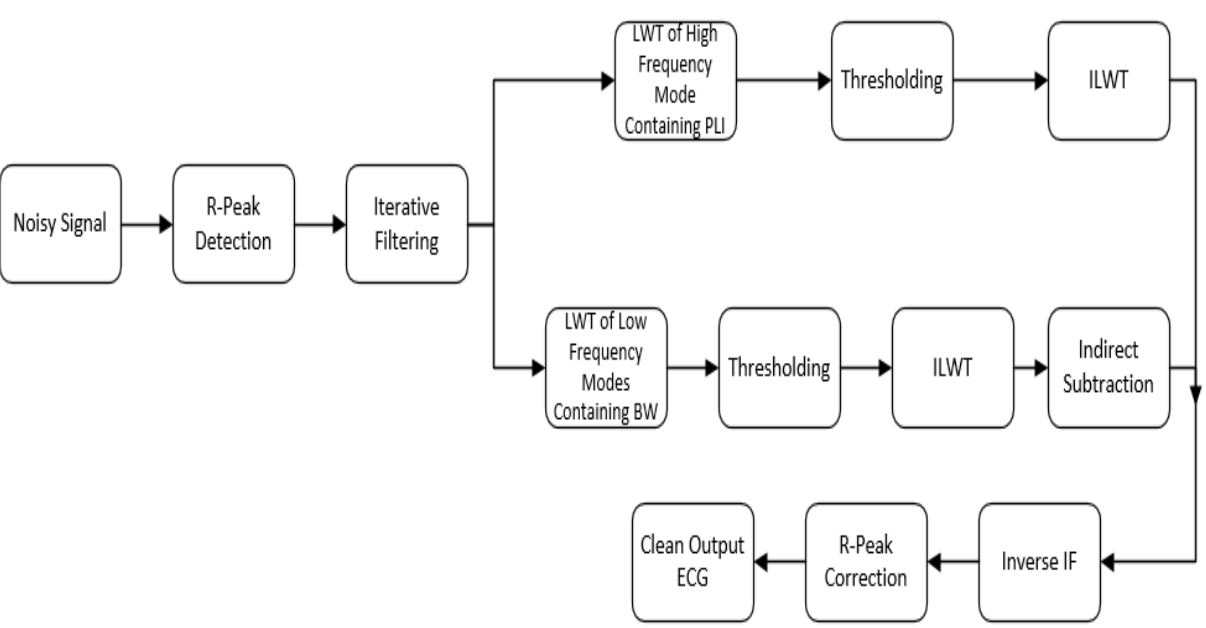
Figure 3. Block diagram of the proposed denoising process.